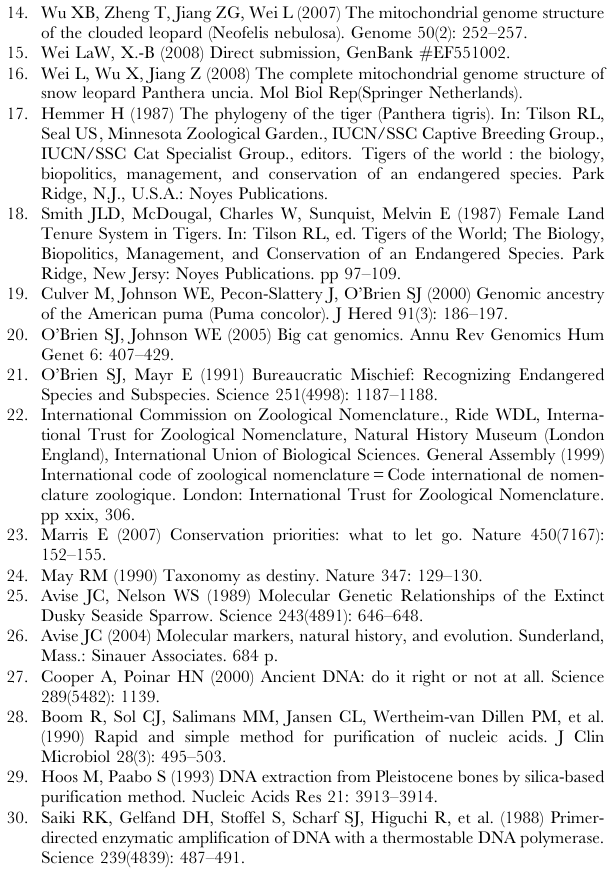
Table S1 Caspian tiger specimens studied Found at: doi:10.1371/journal.pone.0004125.s001 (0.06 MB